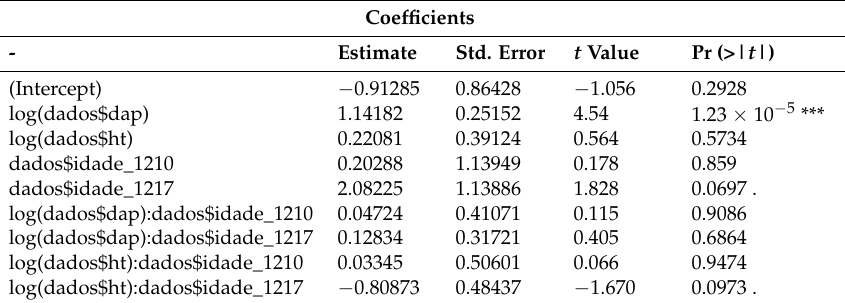
Table A10. R software output table with significance values resulting from ANCOVA for CDM using C 12 as reference for comparison with C 10 and C 17.